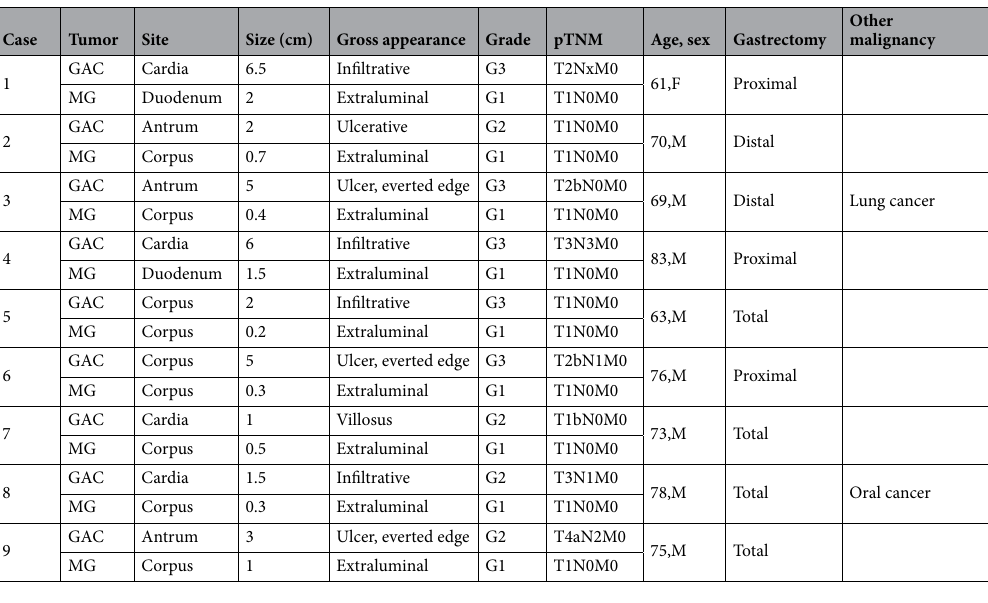
Table 1. Cohort characteristics and clinicopathological features of the tumors. GAC gastric adenocarcinoma, MG microscopic gastrointestinal stromal tumor, F female, M